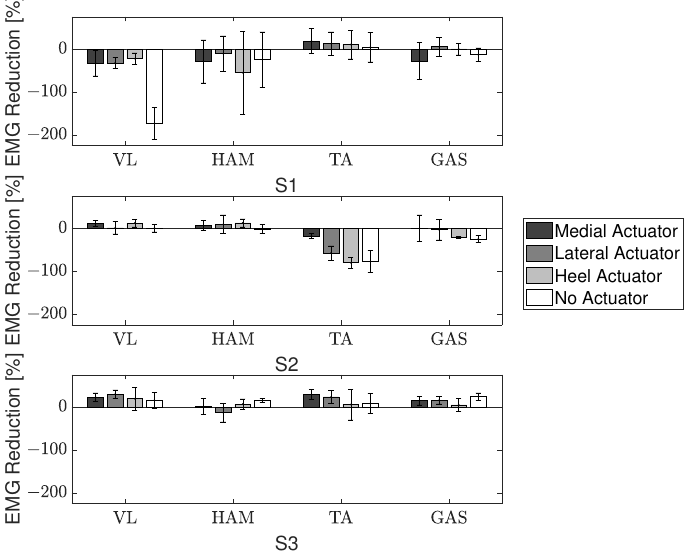
Figure 11. EMG reduction ratio during stance for healthy